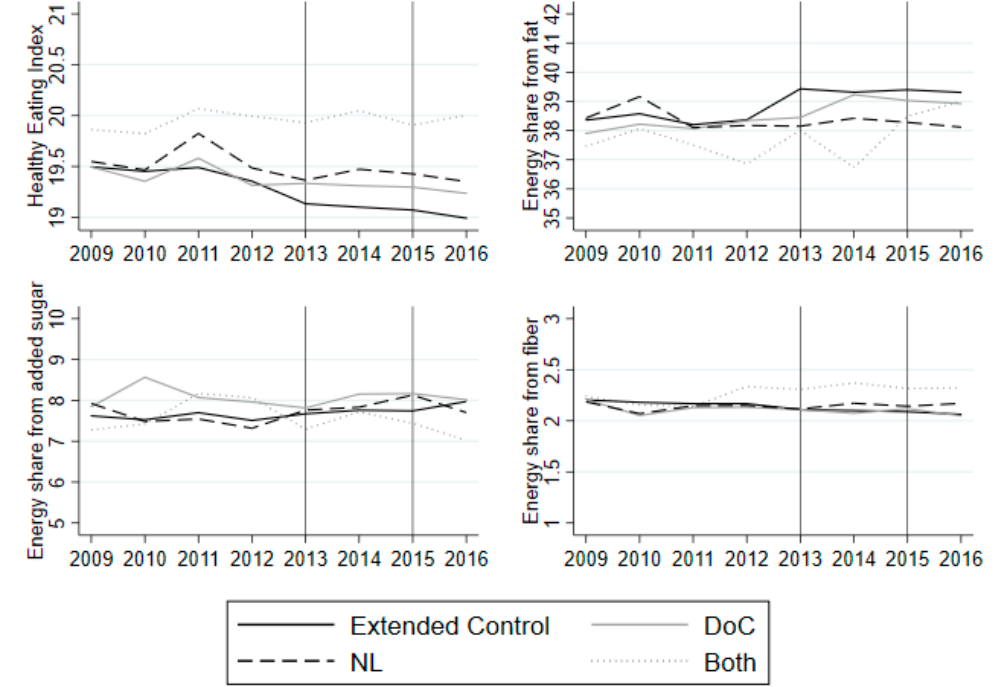
Figure A3. Average HEI and nutrient composition from 2009 to 2016 for NL switchers (grey dashed), DoC switchers (grey solid), Both switchers (light grey dotted) and extended control group (black solid). Note: The vertical lines indicate the years in which the questionnaires were sent to the panel. The average is based on households that answered both questions on label use in 2013 and 2015. The averages are based on an unbalanced panel from 2009 to 2016, as not all of the household stay in the panel from 2009 to 2016. Table A9. Test of common trend of NL switchers, DoC switchers, Both switchers and extended control group.